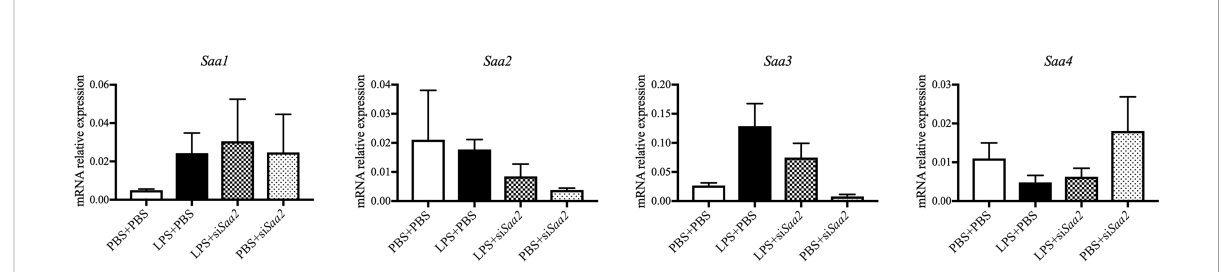
FIGURE 6 siRNA against Saa2 does not change Saa1 – 4 expression in the fetal brain exposed to intrauterine in fl ammation. On embryonic (E) day 17, CD-1 mice underwent a mini-laparotomy in the lower abdomen for intrauterine injection of lipopolysaccharide (LPS). One hour later, dams received intravenous injection of siRNA against serum amyloid A 2 (si Saa2 ) or an infusion of phosphate-buffered saline (PBS). At 24 h postinjection (hpi), dams were sacri fi ced. Fetal brains were harvested from one embryo of each dam. Real time-quantitative polymerase chain reaction (RT-qPCR) on Saa1 – 4 was performed to evaluate the effect of maternal siRNA treatment. PBS+PBS, n = 4; LPS+PBS, n = 7; LPS+si Saa2 , n = 5 – 6; PBS +si Saa2 , n = 3 – 4. Values are expressed as mean ± SEM, one-way